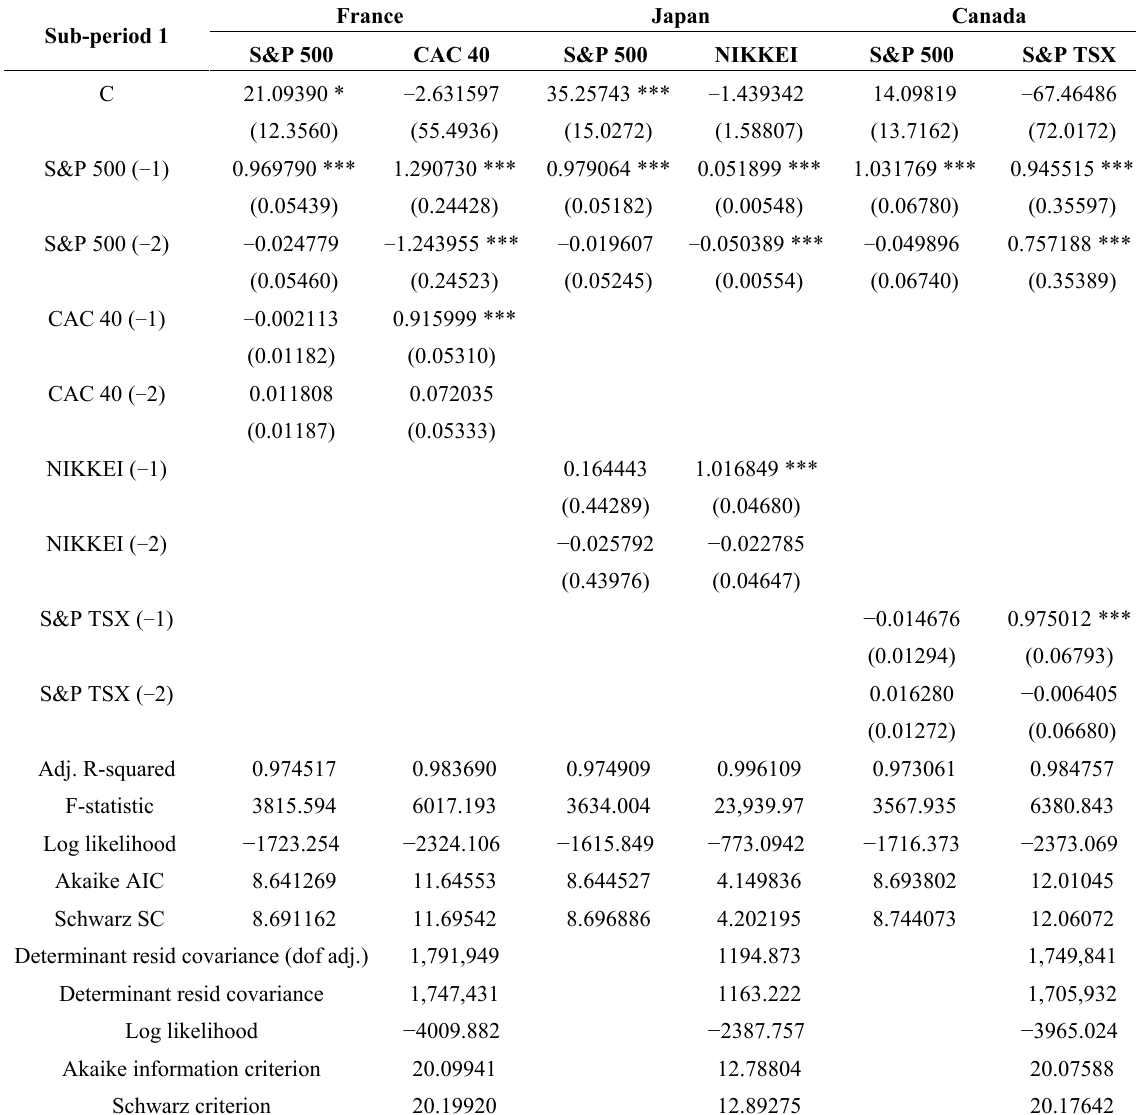
Table A1. Vector Autoregression Estimates for Sub-period